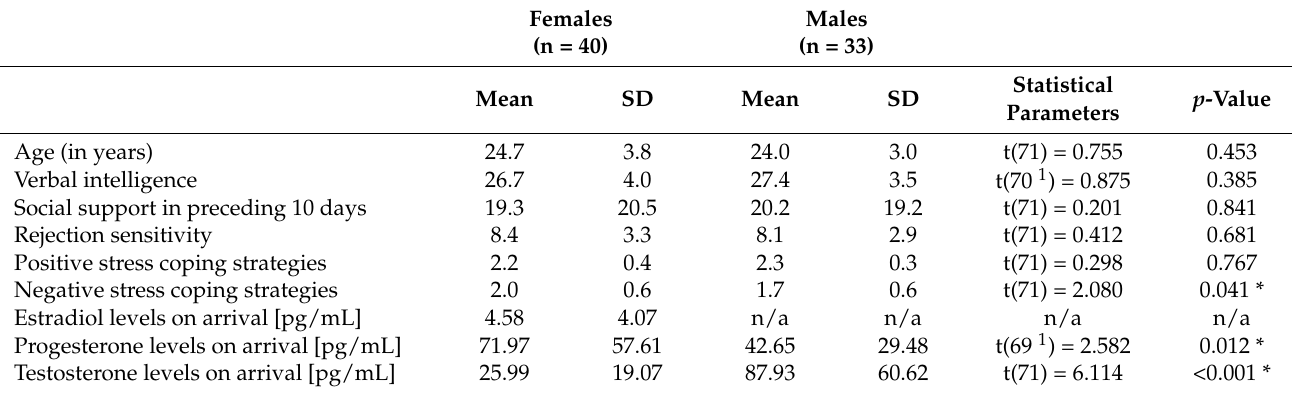
Table 2. Sample description including details of age, questionnaire data, and hormonal concentrations.